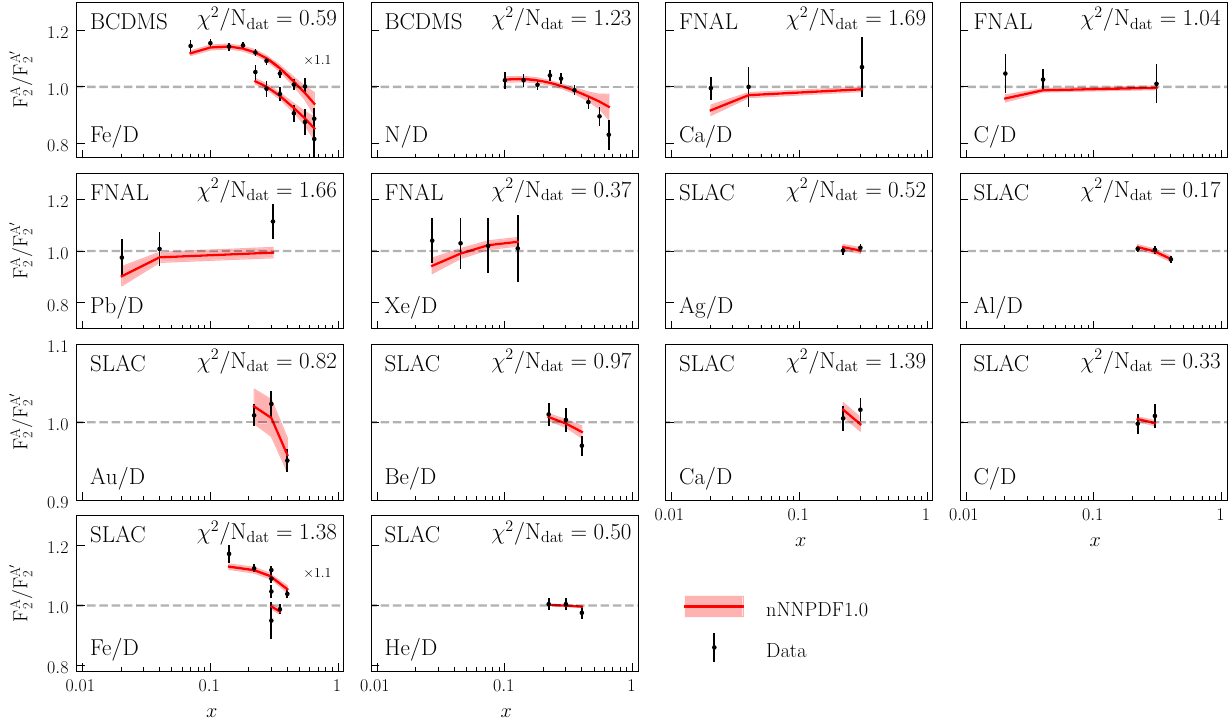
/ F C provided by the NMC experiment 2 2